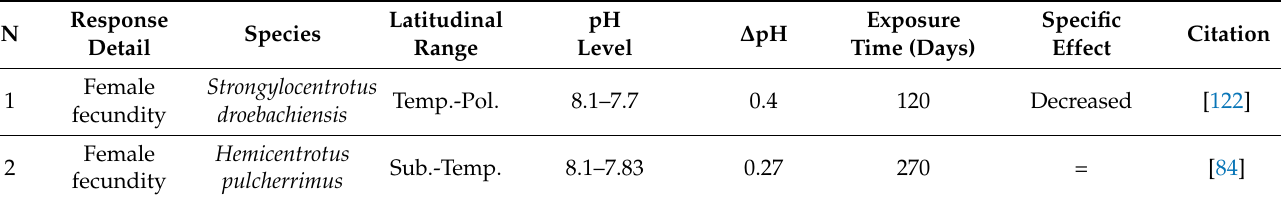
Table 4. List of studies performed on echinoid adult stage to investigate effects of SWA on reproduc- tion. “pH level” contains the values of all the conditions tested; the first value is the control. In the case that the same article tested both a realistic ( ∆ pH ≤ 0.4; based on IPCC RCP8.5) and unrealistic scenario ( ∆ pH > 0.4), the two conditions were split. Abbreviations: Eq.-Trop. = Equatorial–Tropical; Sub.-Temp. = Subtropical–Temperate; Temp.-Pol. =